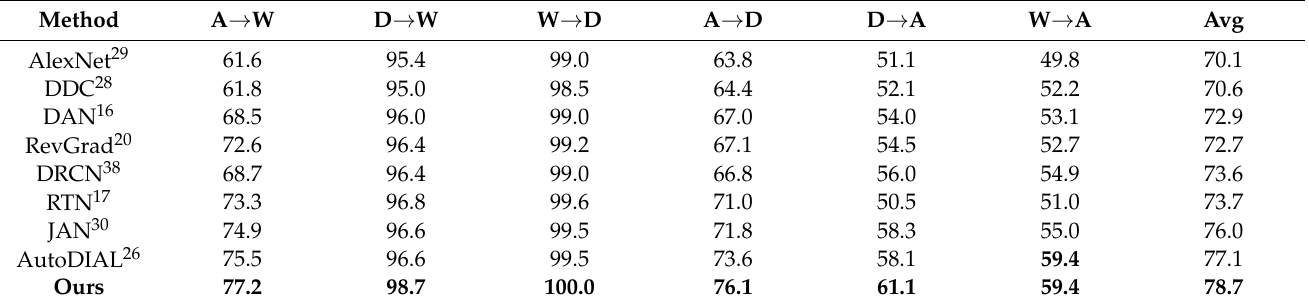
Table 1. Classification accuracy (%) of the Office-31 dataset for unsupervised domain adapta- tion (AlexNet).